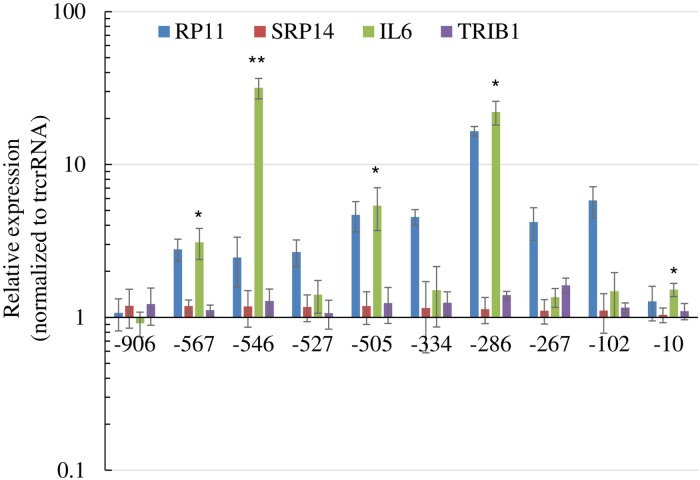
Increased expression of IL6 by CRISPRa directed toward several regions of RP11 promoter.HEK293T transfected with dCas9-VPR and sgRNA constructs were analyzed. Values for RP11 represent the average from 3 distinct primer combinations spanning exons 1–2, 2–3, and 3–4. Two specificity controls (SRP14 and TRIB1) are included. Expression values were normalized first to PPIA and then to a within experiment control transfected with dCas9-VPR and the empty trcrRNA expressing plasmid. Results represent the average of 3 biological replicates (± S.D.). For simplicity only statistically significant tests for IL6 are shown (*: p<0.05; ** p<0.01).